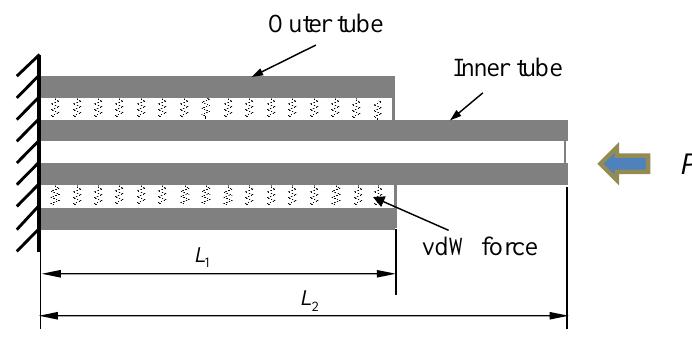
Figure 16. Schematic diagram of clamped CNT with different tube length.